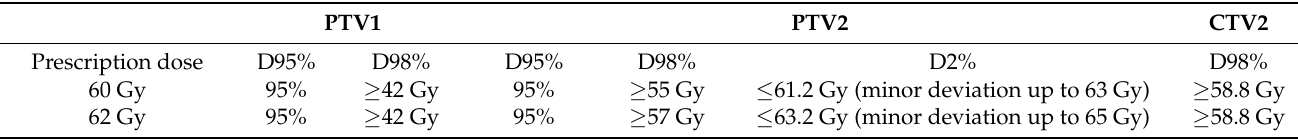
Table 4. Recommendations for the prescription doses of the target volumes (PTVs) for moderate hypofractionation (control arm). PTV1 PTV2 CTV2 Prescription dose D95% D98%